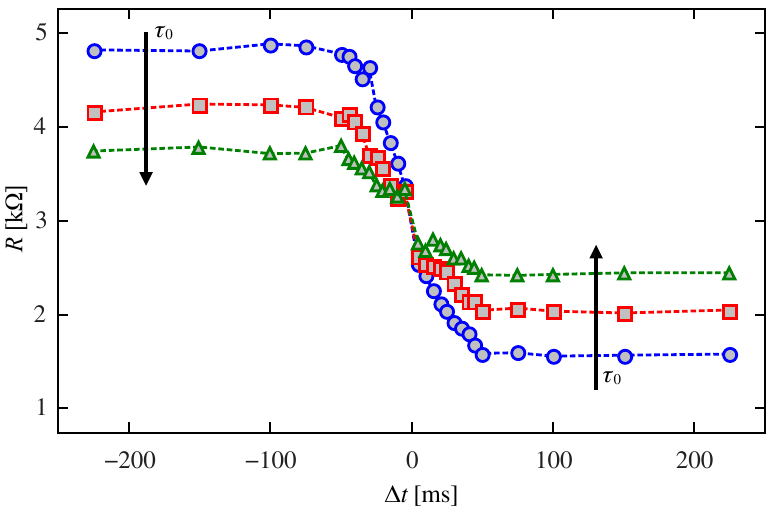
Figure 8. Influence of ∆ t on the emulator resistance for τ 0 = 5 (blue), 10 (red) and 20 s (green). The initial setting was 5 k Ω and the remaining experimental parameters were as in Figure